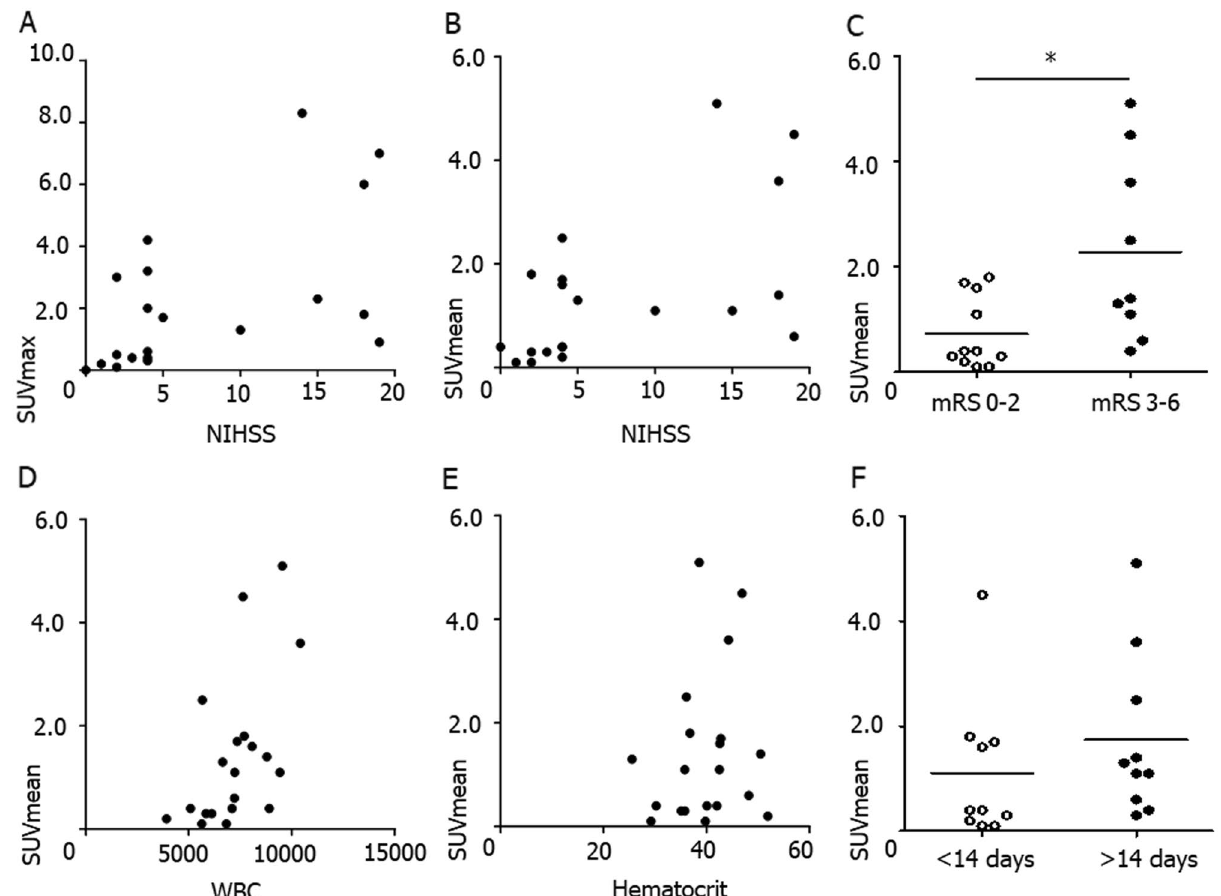
Figure 3. The relationship between NaF uptake and neurological outcome. The correlation analysis between NaF uptake and neurological severity showed that both SUVmax (Spearman’s ρ = 0.579, p = 0.007, A ) and SUVmean (Spearman’s ρ = 0.630, p = 0.003, B ) were significantly correlated with the National Institute of Health Stroke Scale (NIHSS) at admission. The NaF uptake was significantly lower among the patients with modified Rankin scale (mRS) between 0 and 2 than those with mRS greater than 2 at 3 months after stroke (0.35 [0.15– 1.65] versus 1.35 [0.50–4.05], p = 0.030, Mann–Whitney U test, C ). The uptake intensity of NaF was significantly correlated with white blood cell count at admission (Spearman’s ρ = 0.626, p = 0.003, D ), but not with hematocrit (Spearman’s ρ = 0.259, p = 0.269, E ). When the patients were dichotomized according to the imaging taken after index stroke, the uptake intensity of NaF was not significantly different between the two groups (0.55 [0.15– 3.15] versus 1.75 [1.25–5.10], p = 0.35, Mann–Whitney U test, F